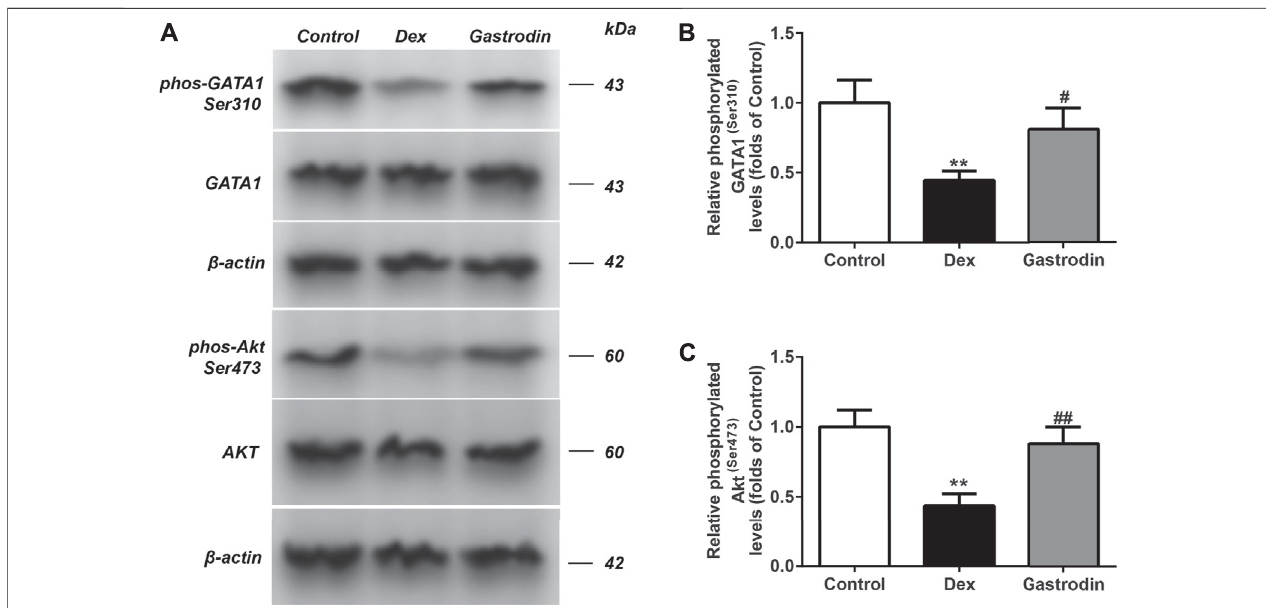
FIGURE 13 | The phosphorylation levels of AKT, GATA1 in HepG2 from different groups were detected by western blot assay, and representative bands were shown in (A) . The phosphorylation levels of GATA1 (B) and AKT (C) were normalized to Dex. The results were presented as mean ± SD ( n (cid:1) 3). ** p < 0.01, vs. Control, ## p < 0.01, vs. Dex.